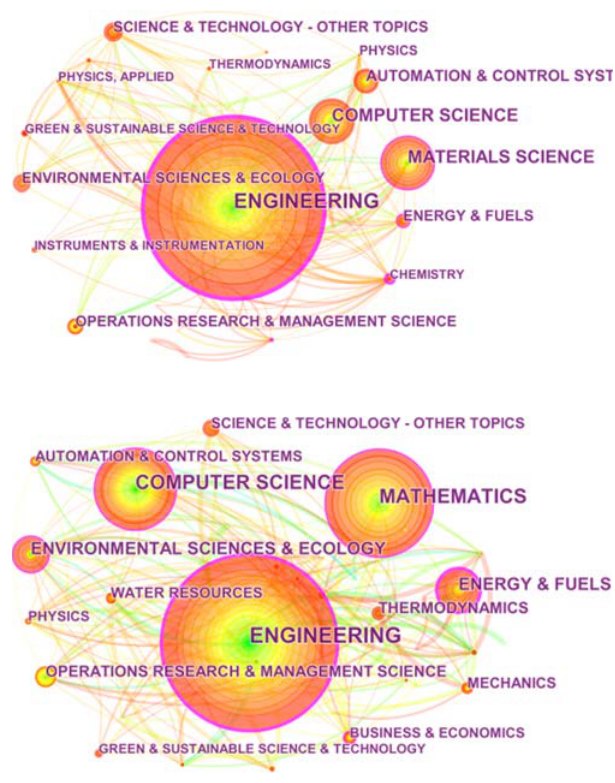
Figure 11. The categories in the grey prediction